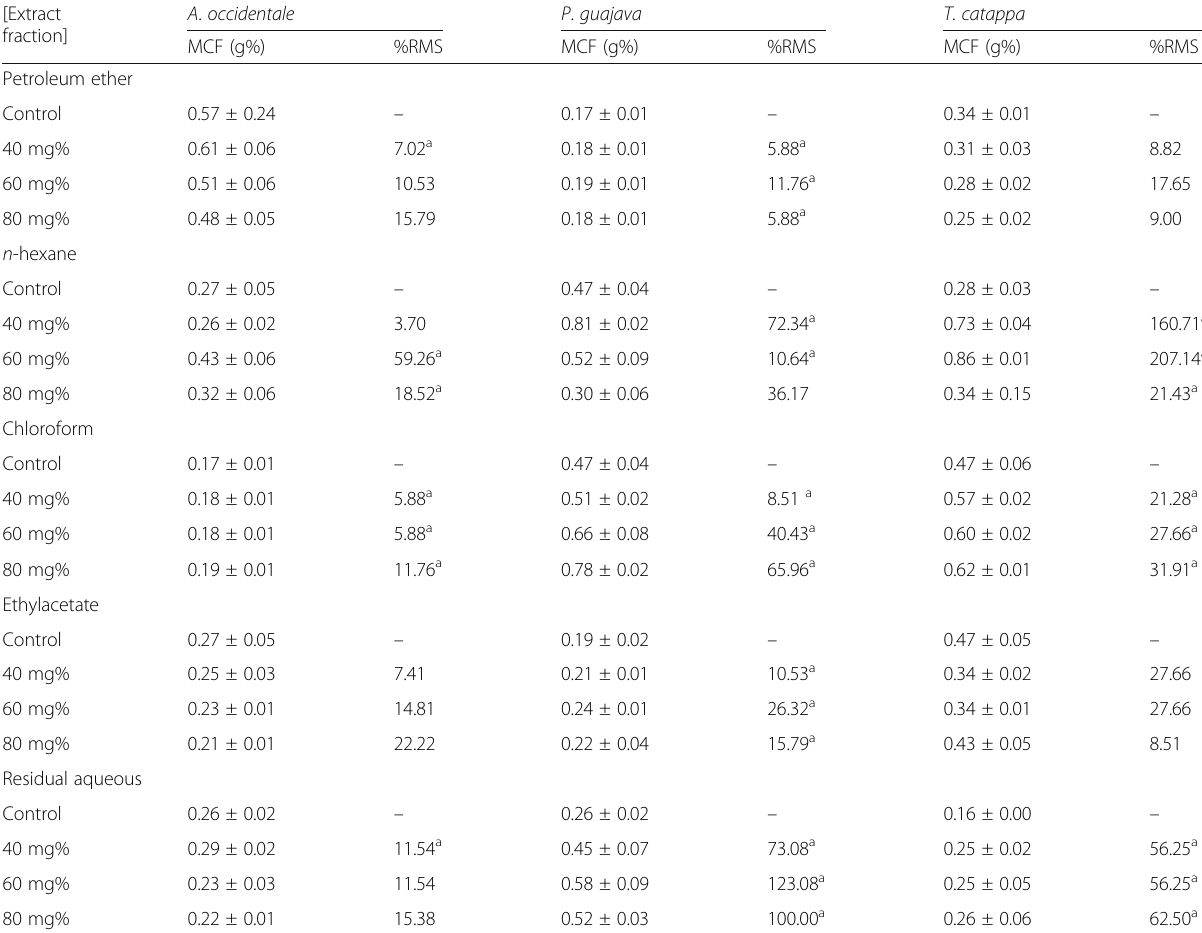
Table 1 Mean corpuscular fragility and percentage stability of sickle erythrocytes in the presence of fractionated leaf extracts of A . occidentale , P . guajava , and T . catappa [Extract